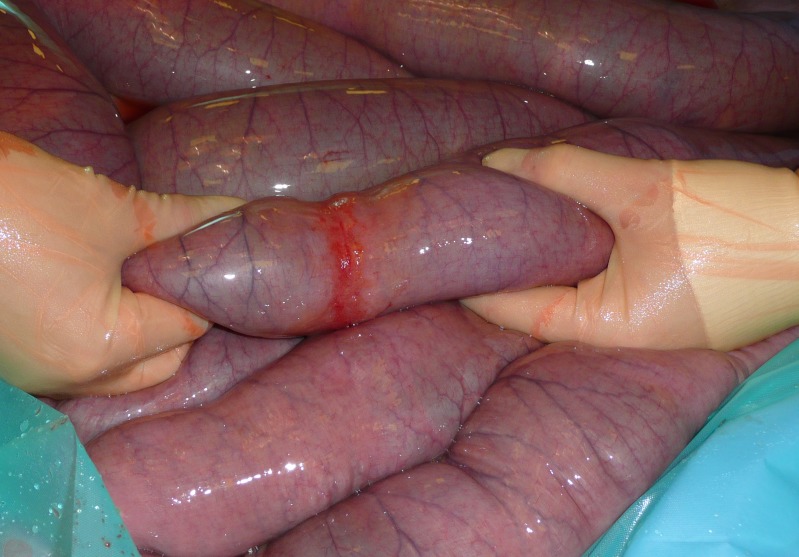
The typical visual appearance of an idiopathic focal eosinophilic enteritis IFEE lesion at laparotomy.The lesion is grossly hyperaemic and spans all or part of the circumference of the small intestine (small bowel). Palpably the tissues are markedly thickened at the site of the lesion and most commonly there is obstruction of ingesta proximal to the lesion(s) resulting in a simple obstruction of the bowel.